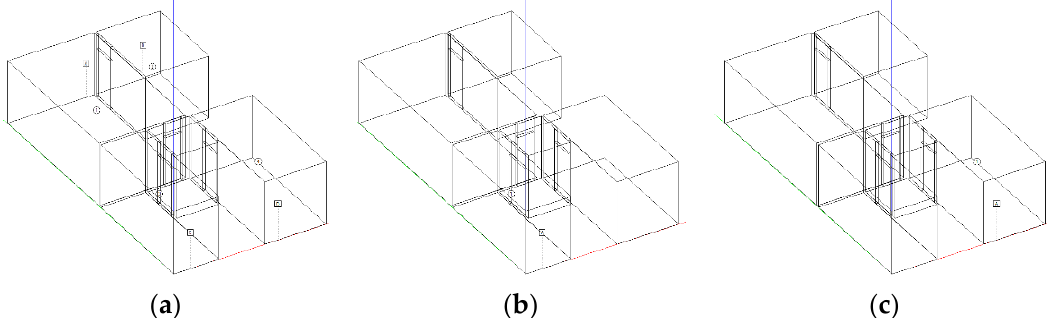
Figure 15. Three-room apartment. “Night” configuration: ( a ) all CVM on, ( b ) only bedroom 8.76 m 2 CVM on, ( c ) only bedroom 12.08 m 2 CVM on.